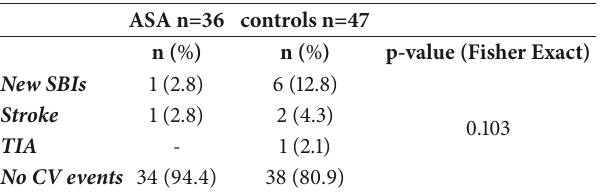
Table 4: Number and rates of secondary endpoints, tolerability and drop out occurrences during the